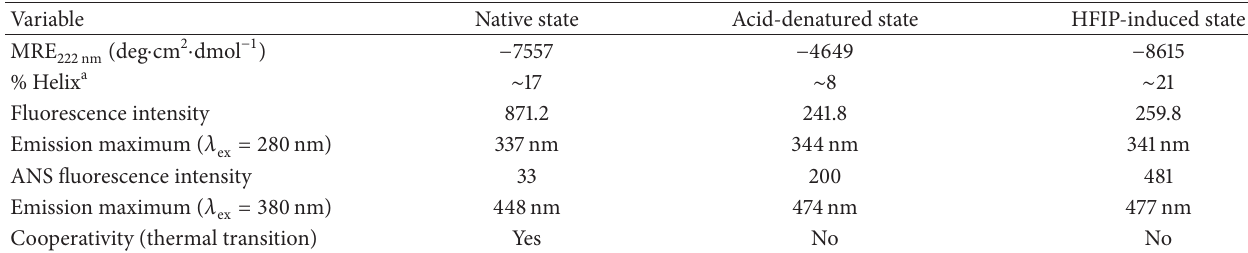
Table 1: Physical characteristics of different conformational states of